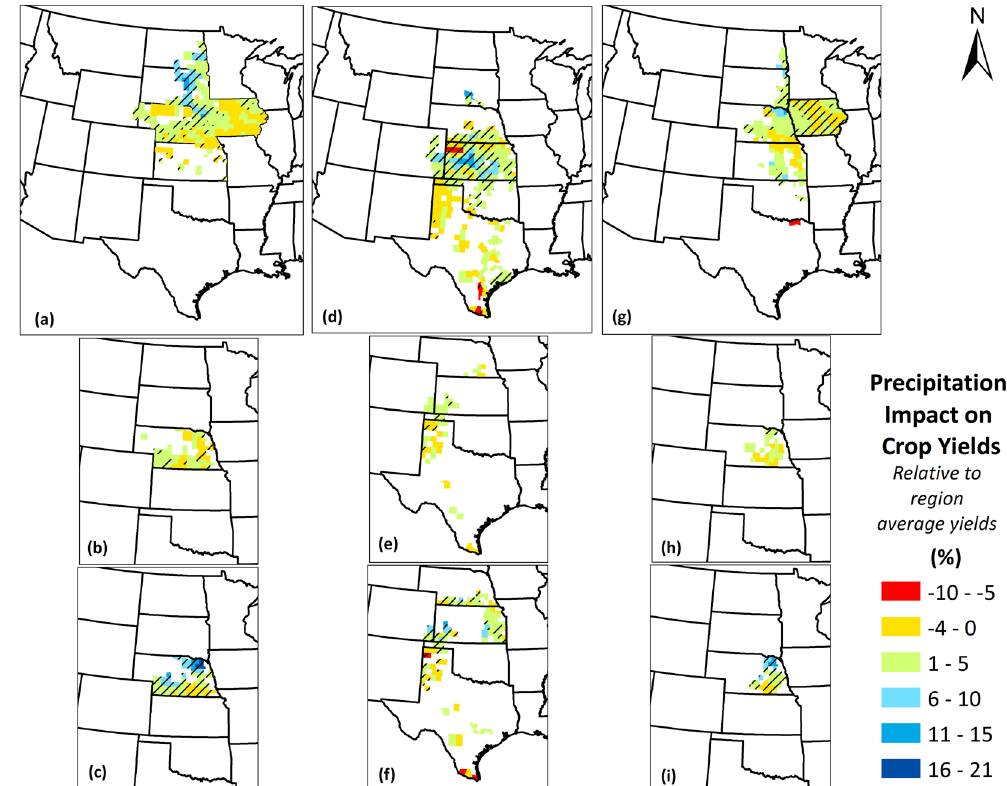
Figure 11. Precipitation-induced crop yield impacts for ( a ) Maize; ( b ) Irrigated maize; ( c ) Non-irrigated maize; ( d ) Sorghum; ( e ) Irrigated sorghum; ( f ) Non-irrigated sorghum; ( g ) Soybean; ( h ) Irrigated soybean; ( i ) Non-irrigated soybean yields in the Great Plains counties over the period 1968–2013. Values are represented as percentage of region-average yields. A positive sign indicates that the observed trends in precipitation whether increasing or decreasing, have positively impacted crop yields, while a negative sign indicates that observed trends in precipitation have negatively impacted crop yields. Counties with striped lines indicate that the precipitation-induced impacts were statistically significant at 90% confidence level. We created the maps using ESRI ArcMap 10.4.1 software